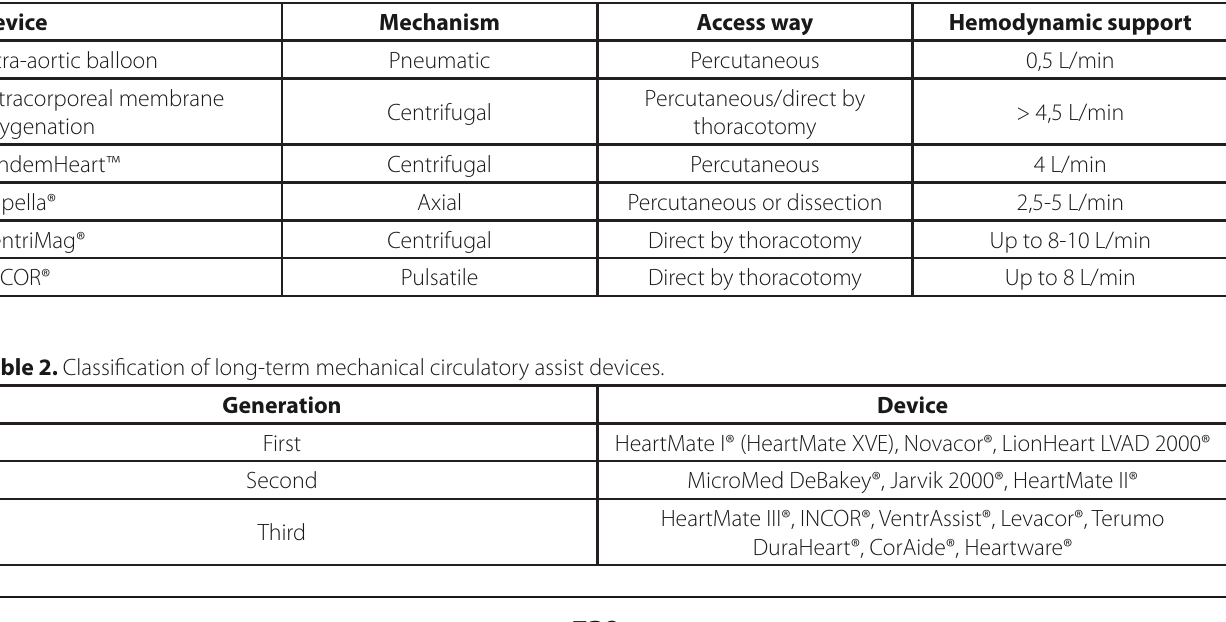
Table 1. Main short-stay devices used in Brazil.